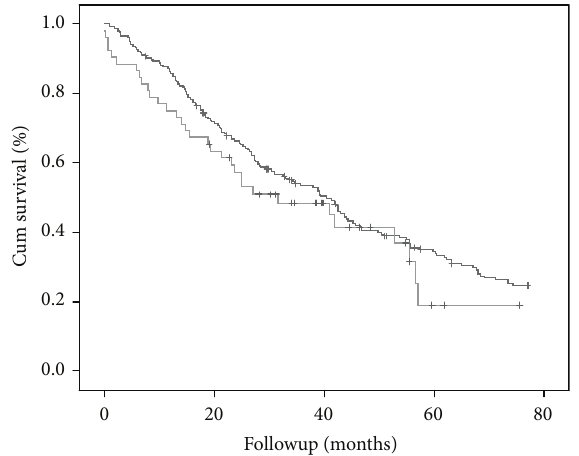
Figure 3: KM survival curve after propensity-matched adjustment. The darker grey line corresponds to the non-PM group and the lighter grey to PM group. There are no differences regarding survival between both groups ( 𝑃 = NS).